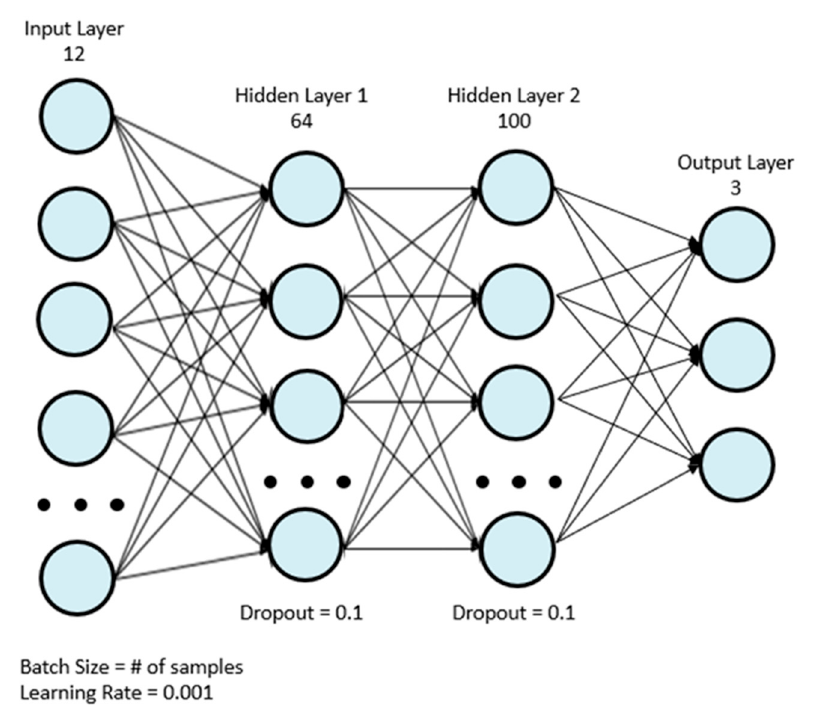
Figure 1. Original MLP model used in the in-lab study by Wong et al. [20]. Table 2. Architecture of the original MLP model by Wong et al. [20].